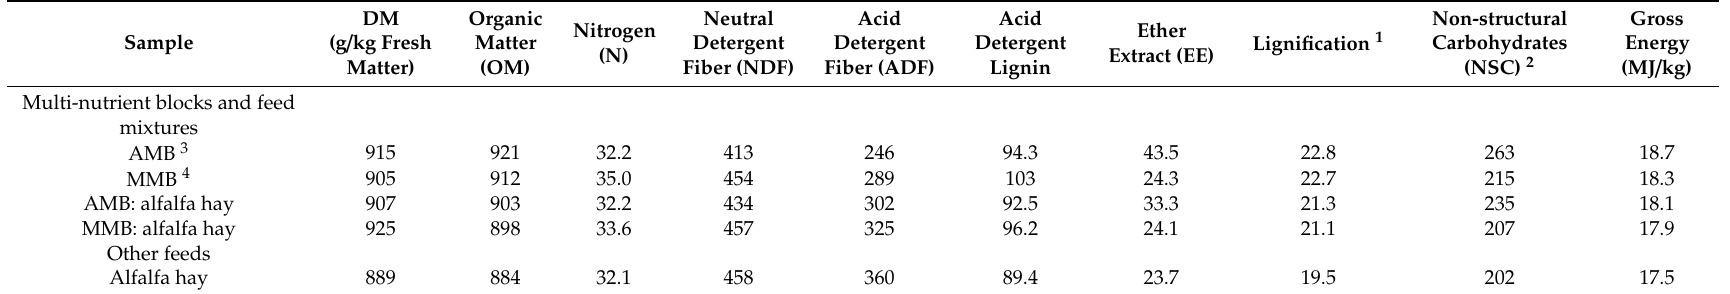
Table 4. Chemical composition (g / kg dry matter (DM) unless otherwise stated) of multi-nutrient blocks containing avocado (AMB) and mango (MMB) wastes, mixed diets composed of 1:1 alfalfa hay and multi-nutrient blocks, and alfalfa hay tested in Experiment